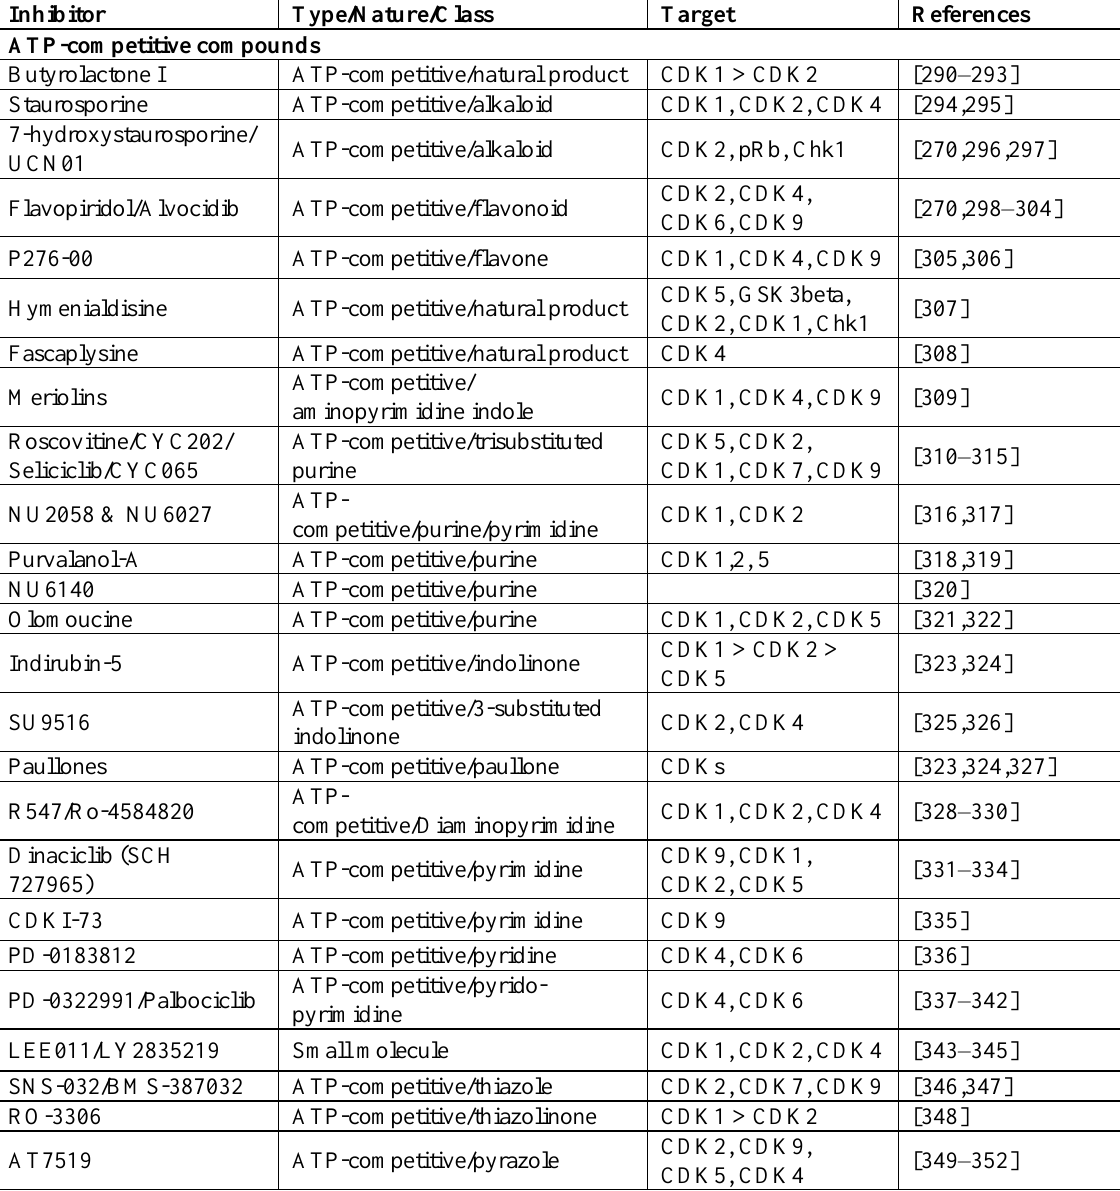
Figure 5. Strategies for targeting Cyclin-dependent Kinases. ( A ) ATP-competitive inhibitors bind the ATP pocket and compete with ATP binding; ( B ) Protein-protein interface inhibitors target essential and specific protein/protein interactions either between CDKs and Cyclins, or between CDK/Cyclins and p21/p27/p107 proteins-targeting the cyclin-binding groove. The example shown here represents an inhibitor targeting the primary interface between the CDK and the cyclin [the “PSTAIRE” helix of the CDK and alpha 5 helix of the cyclin]. ( C ) Allosteric inhibitors preventing ATP binding target sites which are remote from the ATP- pocket, so as to stabilize enzymatically inactive conformations or interfere with conformational transitions associated with kinase activation, compete with substrate or ATP binding. Table 3. Major CDK